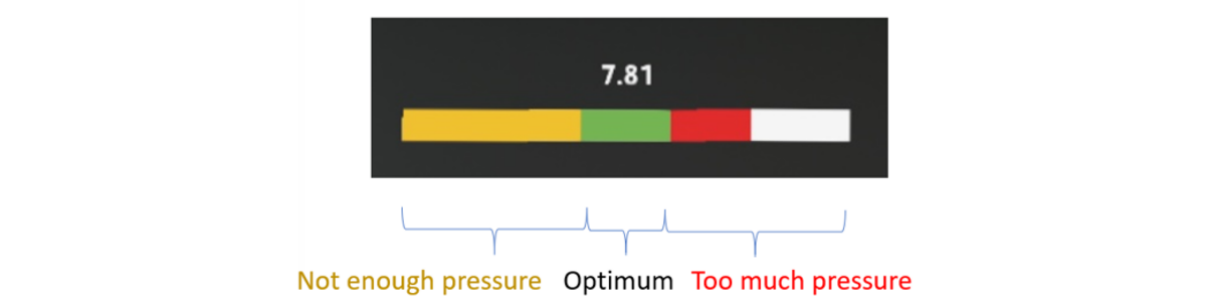
Figure 11. Real-time visualization of force applied by the examining